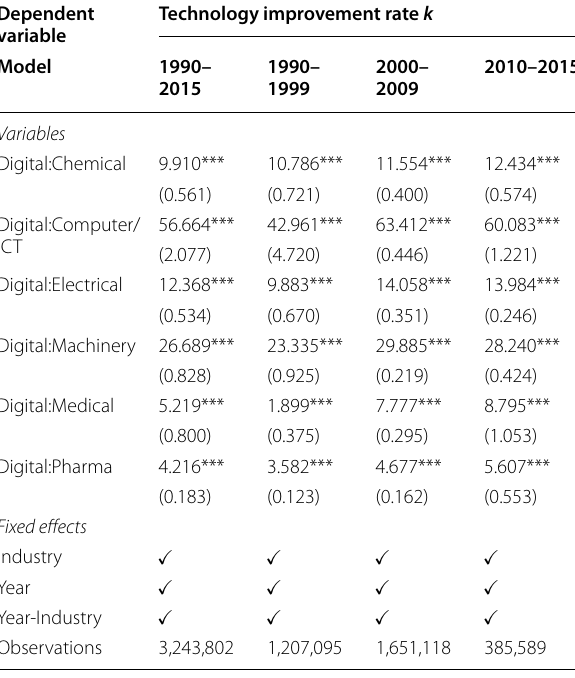
Table 11 Technological improvement rates and breakthrough innovations across industries: different time spans of forward citations